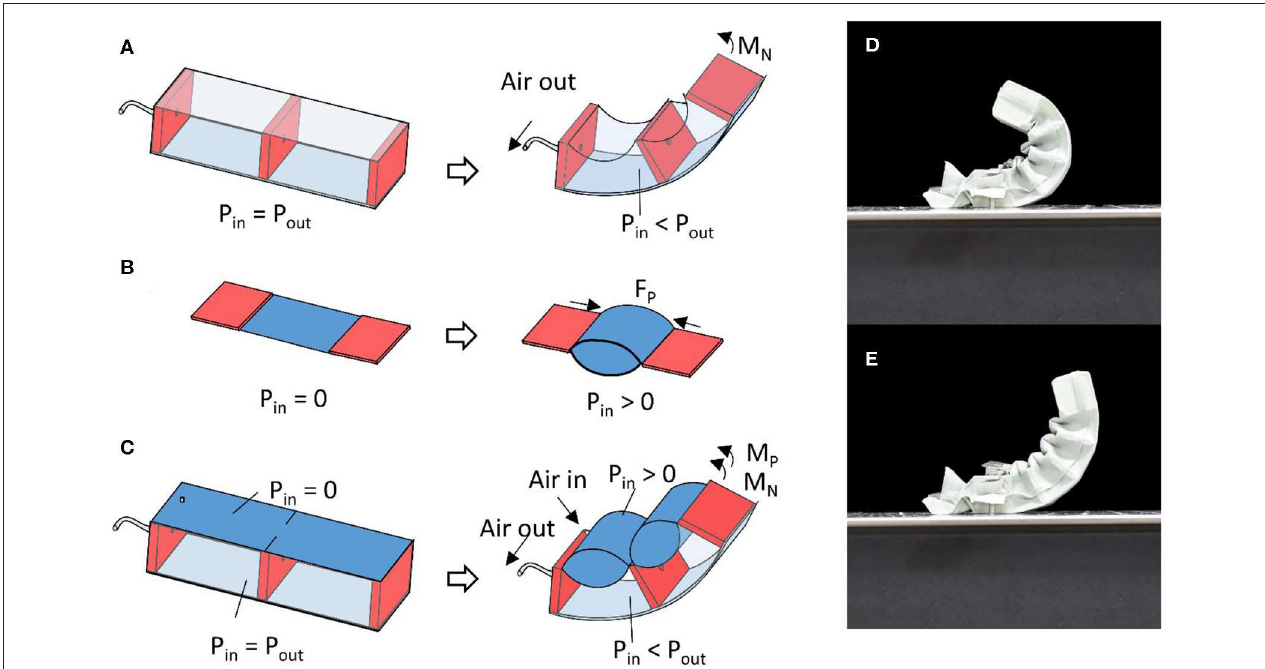
FIGURE 1 | (A) Bending deformation of the actuator with only negative pressure actuation, (B) linear motion of a pouch motor, and (C) bending deformation of the actuator combining PNP actuation. Equilibrium of the actuator using (D) negative pressure actuation only and (E) PNP actuation.